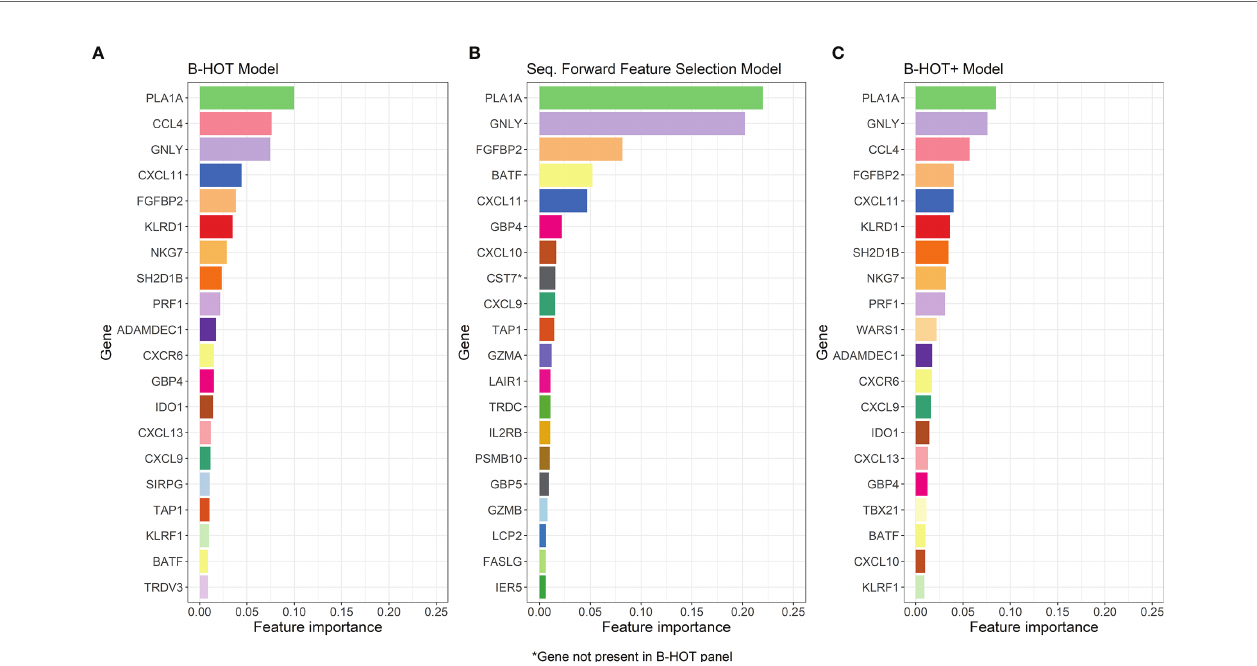
FIGURE 4 | Overview of the Most-Predictive Features of the three Random Forest Models. (A) The twenty most predictive features for classi fi cation within GSE98320 of the B-HOT Model. (B) The twenty most predictive features for classi fi cation within GSE98320 of the Forward Sequential Feature Selected Model. (C) The twenty most predictive features for classi fi cation within GSE98320 of B-HOT+ Model. B-HOT, Banff-Human Organ